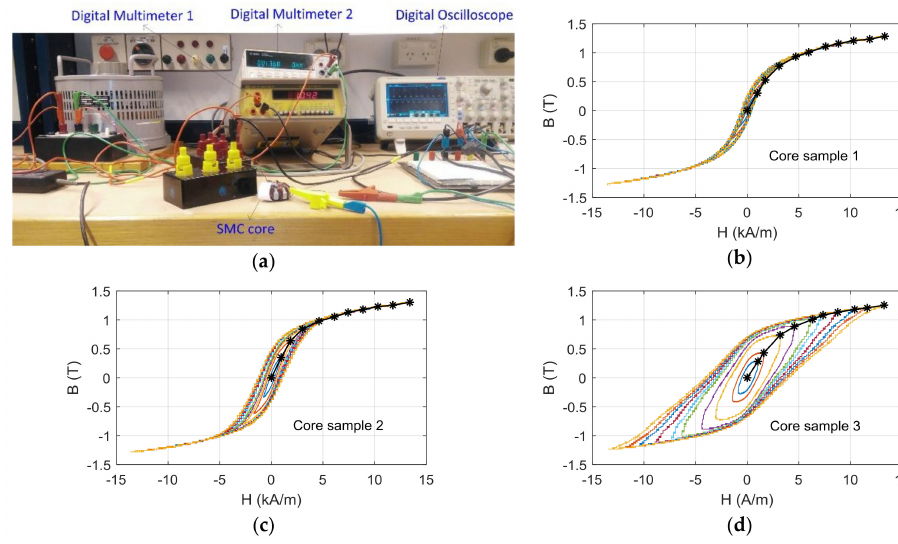
Figure 5. ( a ) An experimental platform for SMC cores, ( b – d ) measured magnetization curves for cores 1–3.